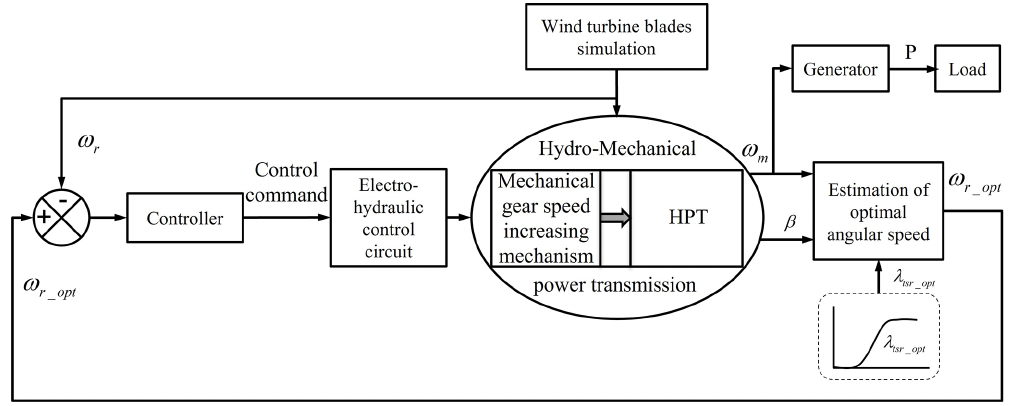
Figure 4. Block diagram to obtain optimum rotor speed.